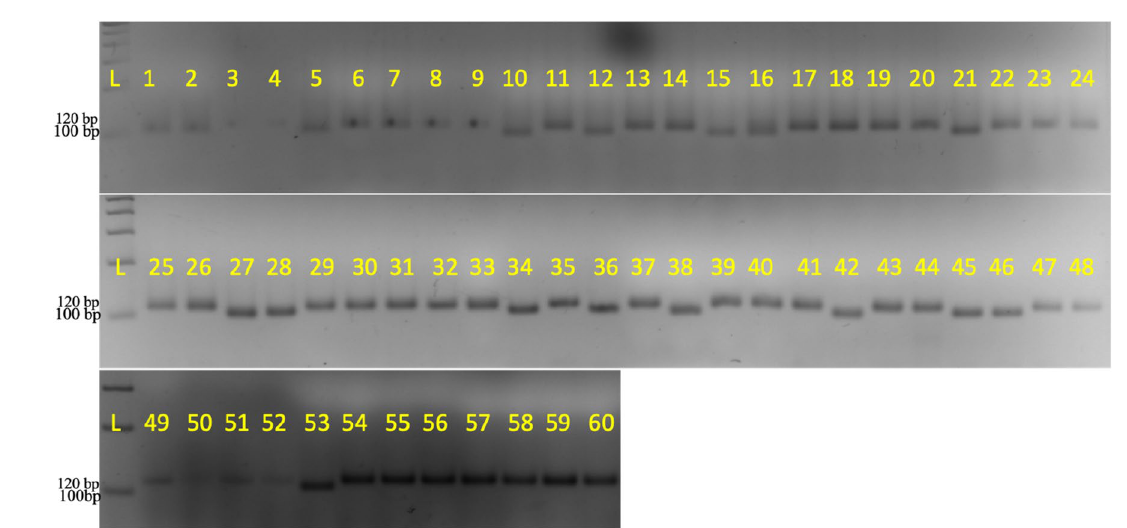
Figure 5. Banding pattern of BSOY 29 marker alleles in 60 genotypes ( L Ladder) (The gel with serial number 49–60 was cropped from different gel and the full-length image is included in Supplementary Fig. S1).